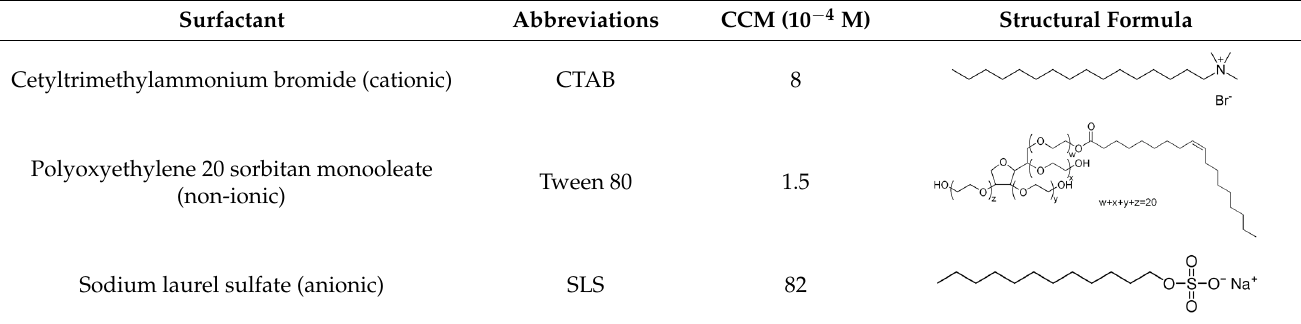
Table 3. Characterization of the surfactants used in this study.